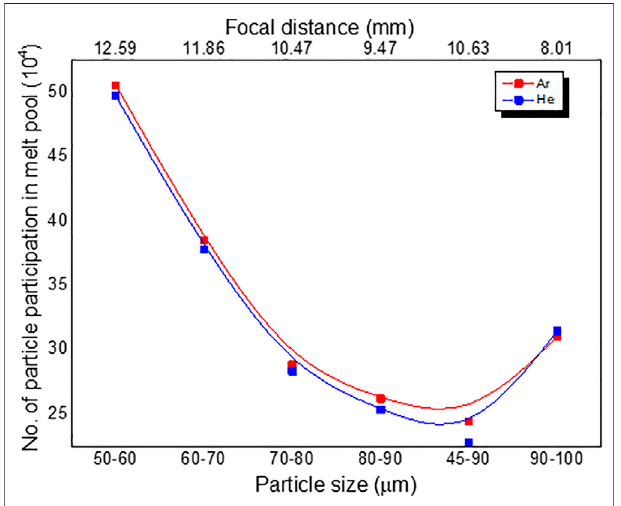
FIGURE15| Stainlesssteelpowderparticleparticipationinmeltpool vs . various powder size of argon and helium as carrier gas.